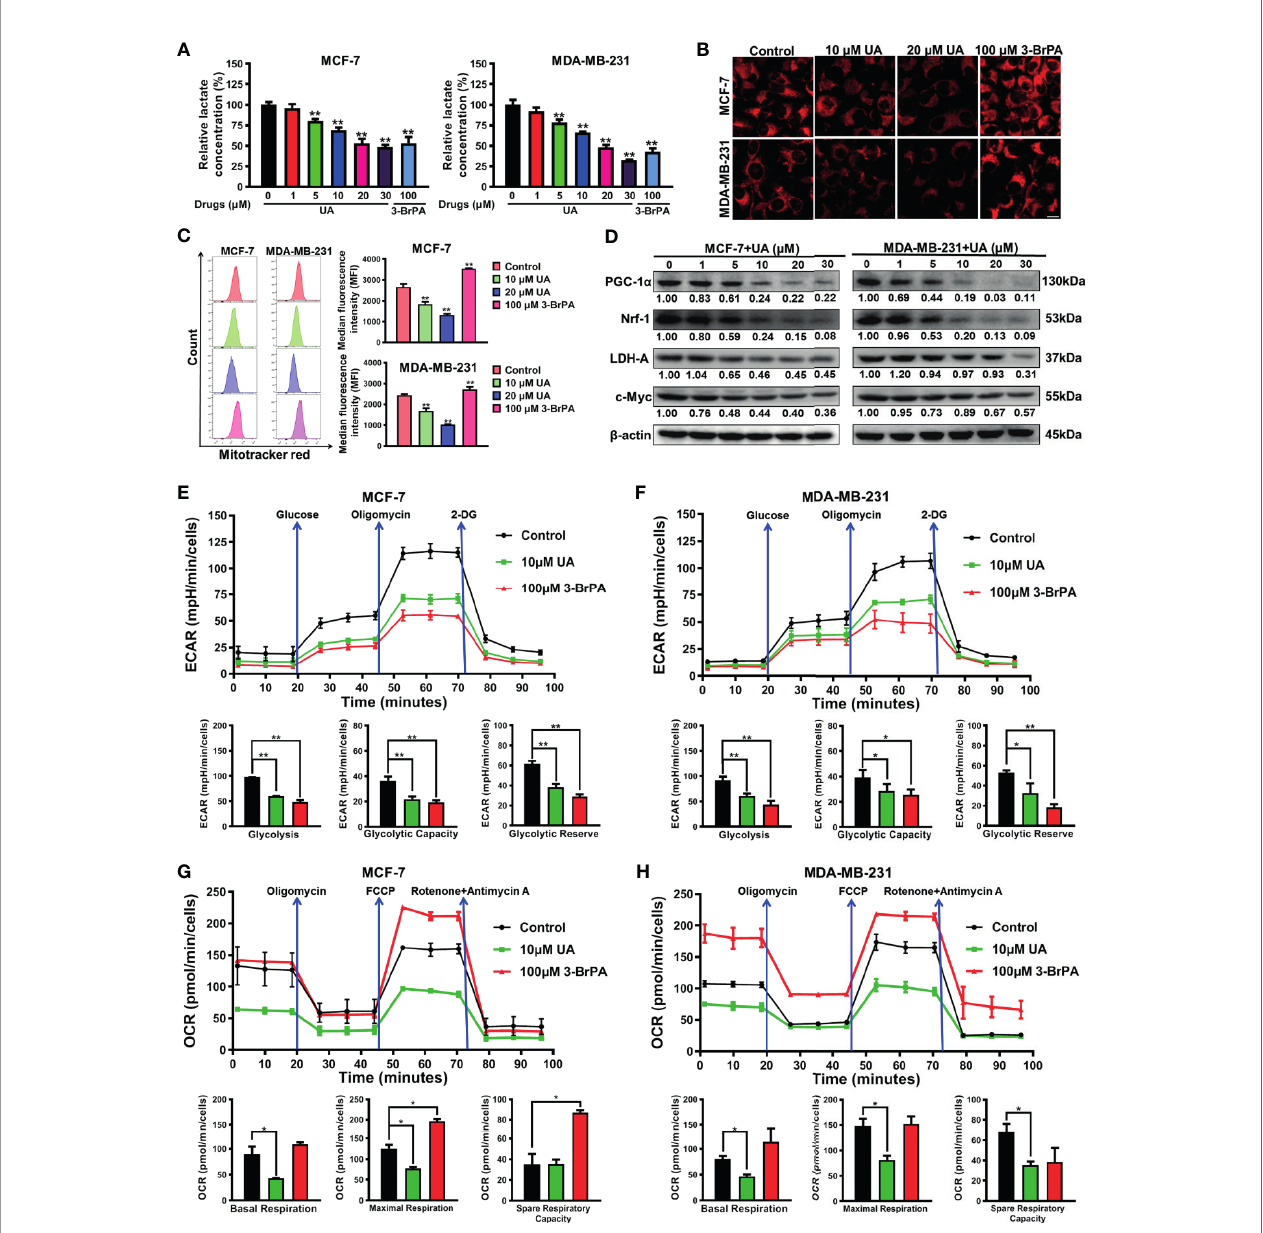
FIGURE 3 | Ursolic acid impairs the glycolytic metabolism and mitochondrial respiration function of breast cancer cells. (A) MCF-7 and MDA-MB-231 cells were treated with 1~30 m M ursolic acid or 100 m M 3-BrPA for 48 h The lactate concentrations in cell lysates were detected using the Lactate Assay Kit. (B, C) Breast cancer cells were treated with 10~20 m M ursolic acid or 100 m M 3-BrPA for 24 h Mitotracker-red staining assay and fl ow cytometry were conducted to investigate the accumulation changes of Mitotracker-red in mitochondria of breast cancer cells. Scale bar = 10 m m. (D) The expression changes of the indicated proteins in MCF-7 and MDA-MB-231 cells after ursolic acid (1~30 m M) treatment for 48 h (E – H) MCF-7 and MDA-MB-231 cells were treated with 10 m M ursolic acid or 100 m M 3-BrPA for 24 h The Seahorse XF24 extracellular fl ux analyzer was used to detect OCRs to measure mitochondrial respiration, and to detect ECARs to determine glycolysis. N = 3. * p < 0.05. ** p <